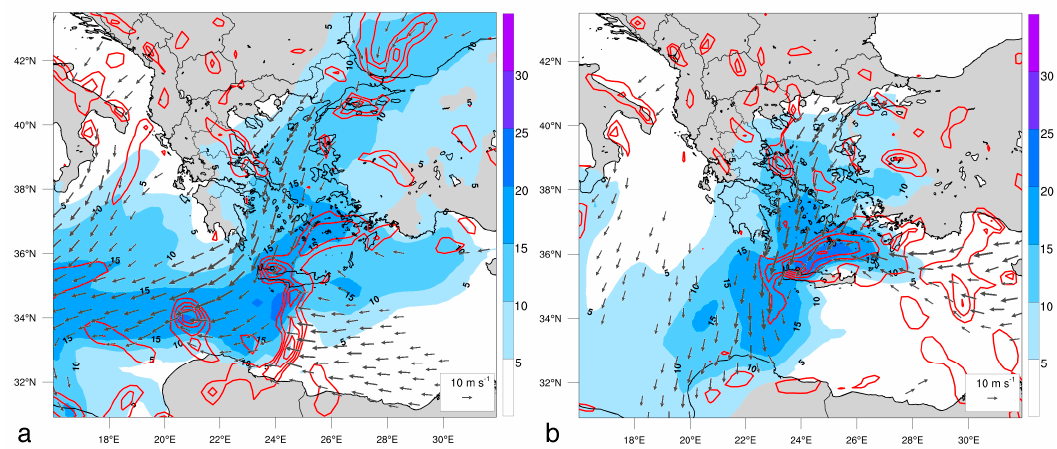
Figure 9. NCEP FNL analysis of effective precipitable water (shading at 5-mm intervals), low-level convergence (red contours at 0.5 × 10 − 4 s − 1 intervals), and 10-m wind (arrows) valid at ( a ) 0000 UTC 25 February 2019 and at ( b ) 1800 UTC 25 February 2019.